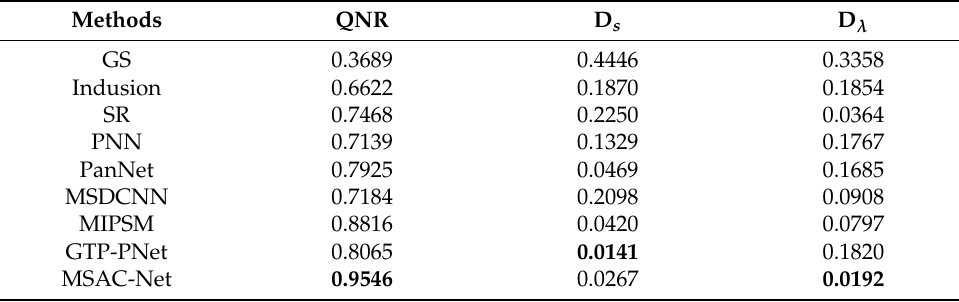
Table 10. Quality metrics of the different methods on the real QuickBird